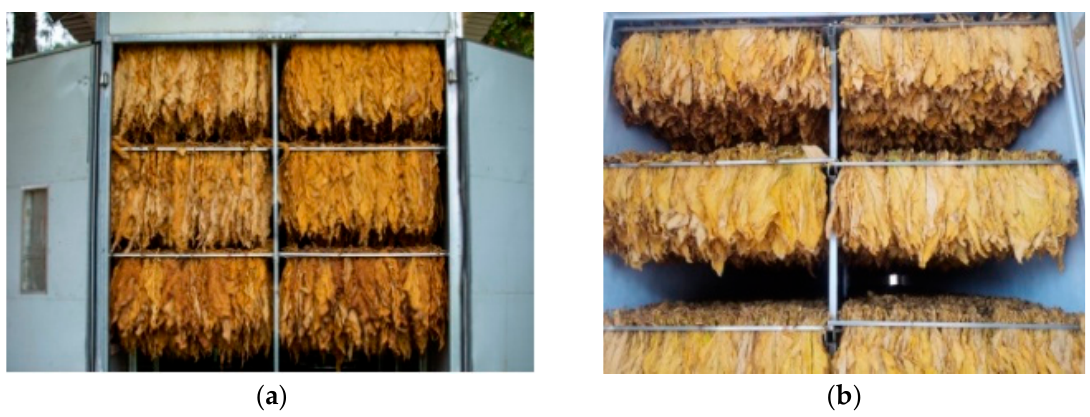
Figure 9. Appearance of tobacco leaves after curing with ( a ) TCCB and ( b ) HPCB